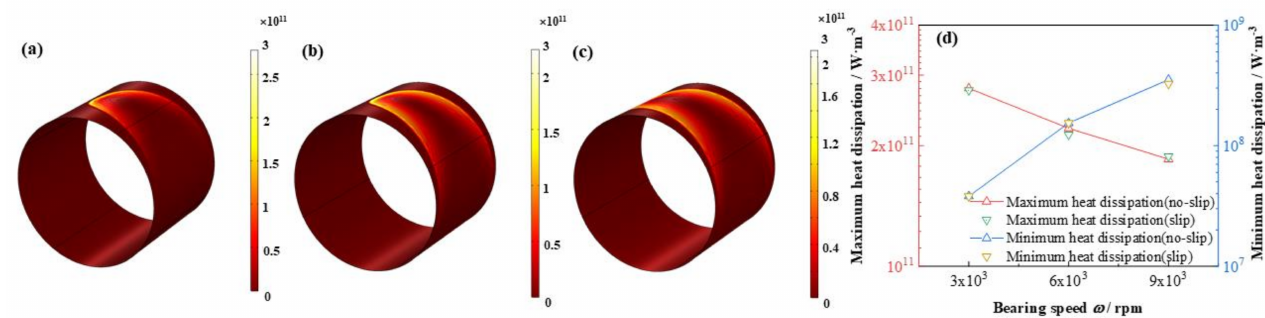
Figure 21. Comparison of the heat dissipation distribution under different bearing speeds. ( a ) ω = 3 × 10 3 rpm;